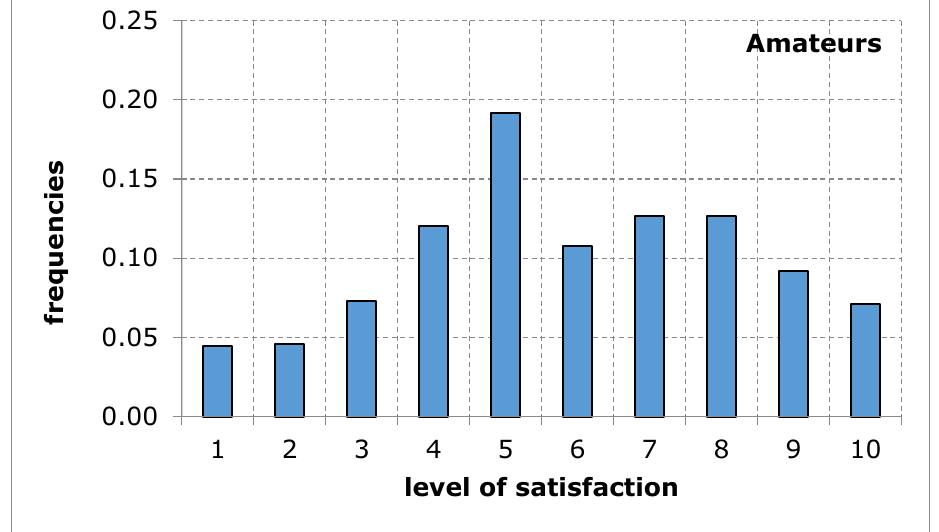
Figure 7. Relatively high prices of services at sports and recreation facilities, in the opinion of service recipients (amateurs). Source: own work.